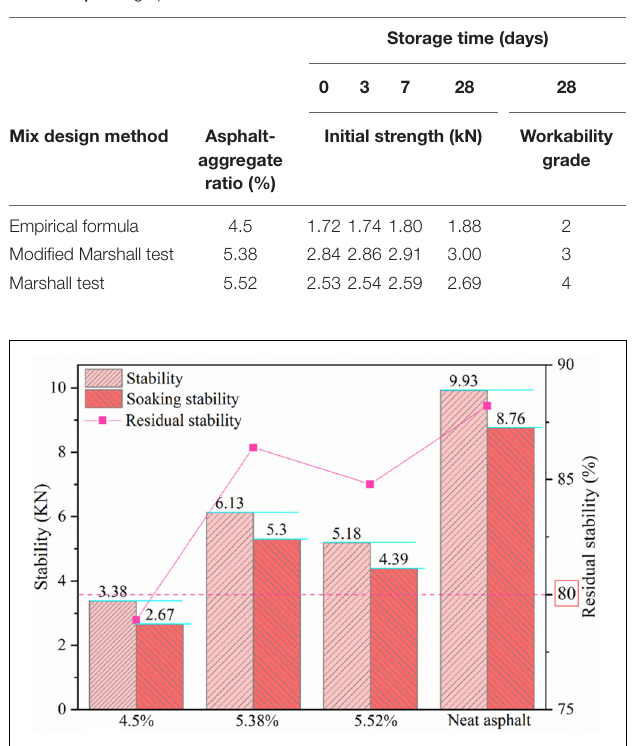
FIGURE 7 | Immersion Marshall test results for CPAM.